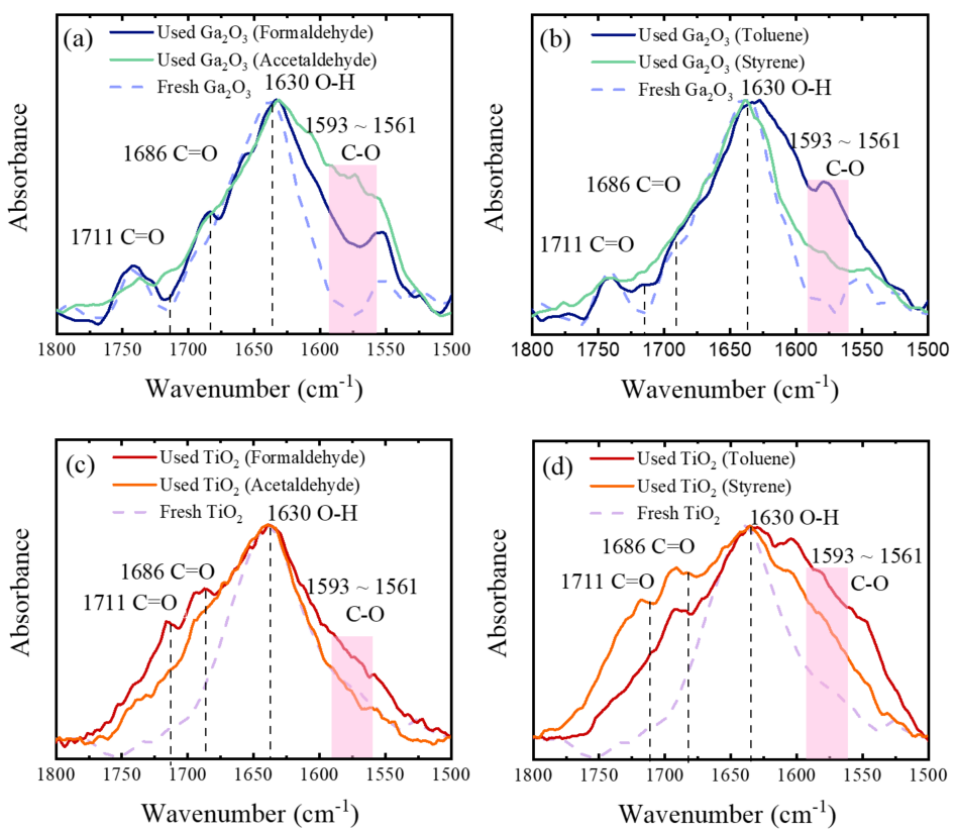
Figure 5. FTIR spectra of ( a , b ) Ga 2 O 3 and ( c,d ) TiO 2 surface before and after photocatalytic degradation of ( a , c ) formaldehyde and acetaldehyde, and ( b , d ) toluene and styrene. The used Ga 2 O 3 and TiO 2 were exposed to UVC under each VOC for 2